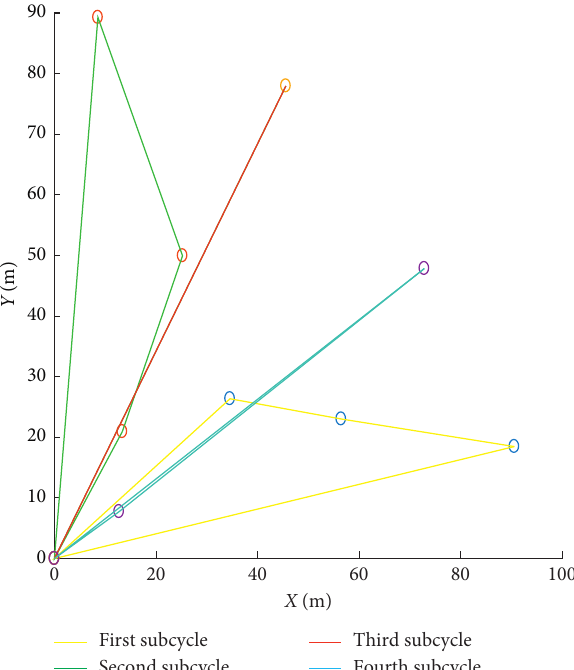
Figure 19: The whole tour planning over the four